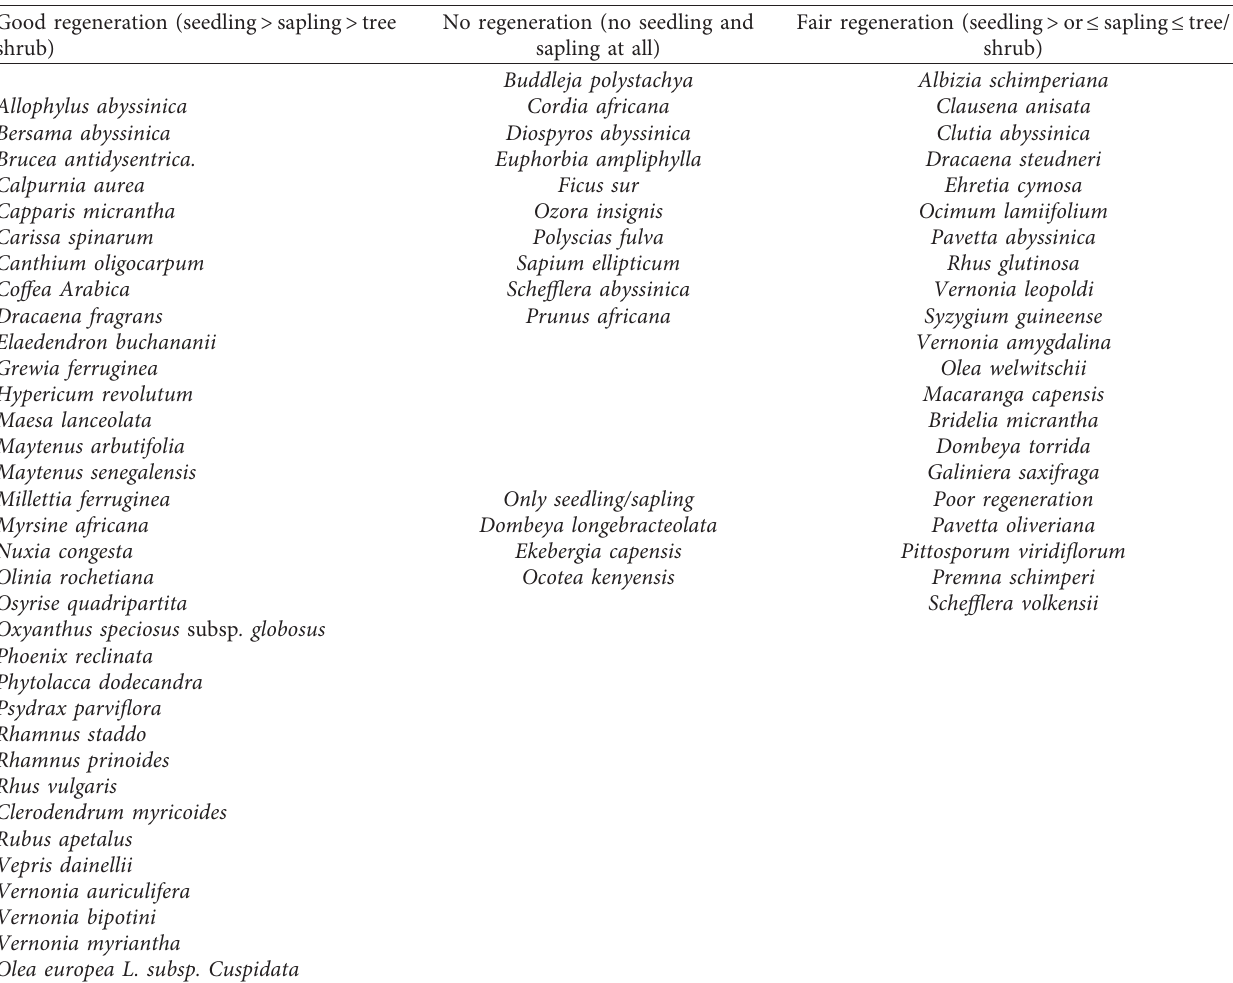
Table 9: Regeneration status of tree/shrub species of Wurg